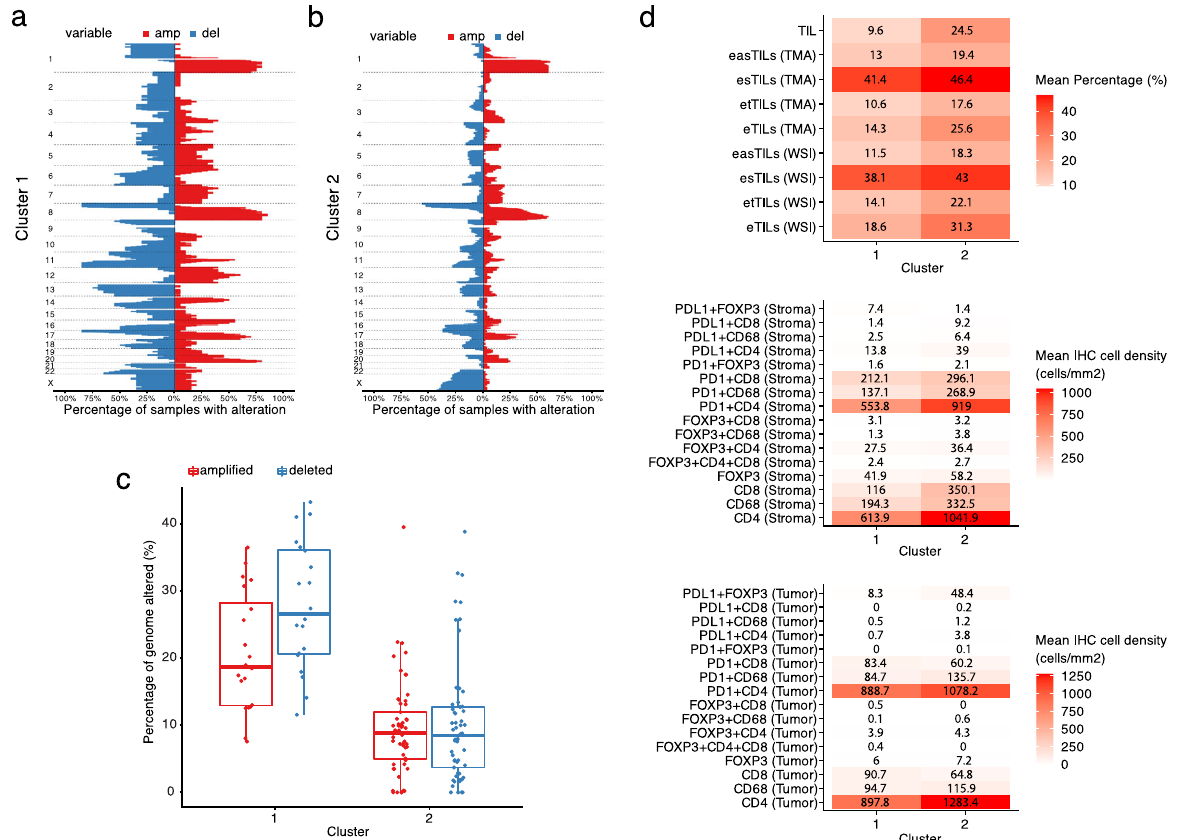
Fig. 5 Combined immunogenomic analysis in the SBG-2004-1 trial. a , b CNA clusters and graph depicting the respective CNA burden (percentage of genome ampli fi ed/deleted); c Distribution of CNA among the distinct genomic clusters. In the boxplots, each box extends from the 25th to the 75th percentile, the midline represents the median, and the whiskers extend from – 1.5× IQR to + 1.5× IQR from the closest quartile, where IQR is the inter-quartile range; d Heatmaps of the mean cell density and expression of the different multiplex immune cell subsets and H&E TIL variables (both manual and digital TILs) within CNA